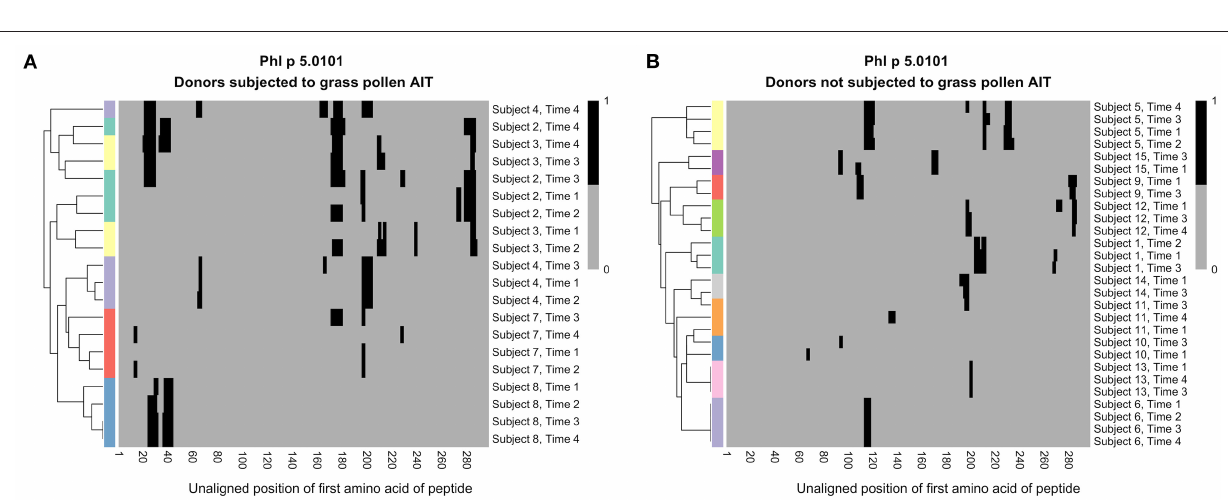
FIGURE 3 | Hierarchical clustering of IgG recognition of Phl p 5.0101 peptides in serum samples collected at AIT treatment initiation (time 1), and 8 weeks (time 2), 1 year (time 3), and 3 years later (time 4). Donor 2 (cyan), donor 3 (yellow), donor 4 (light purple), donor 7 (red), and donor 8 (blue) had been subjected to grass pollen AIT (A) , while donor 1 (cyan), donor 5 (yellow), and donor 6 (light purple) had been subjected to AIT containing non-grass allergens. Donor 9 (red), donor 10 (blue), donor 11 (orange), donor 12 (green), donor 13 (pink), donor 14 (gray), and donor 15 (dark purple) had not been subjected to AIT at all (B) . Clustering was done using euclidean distance and the R package